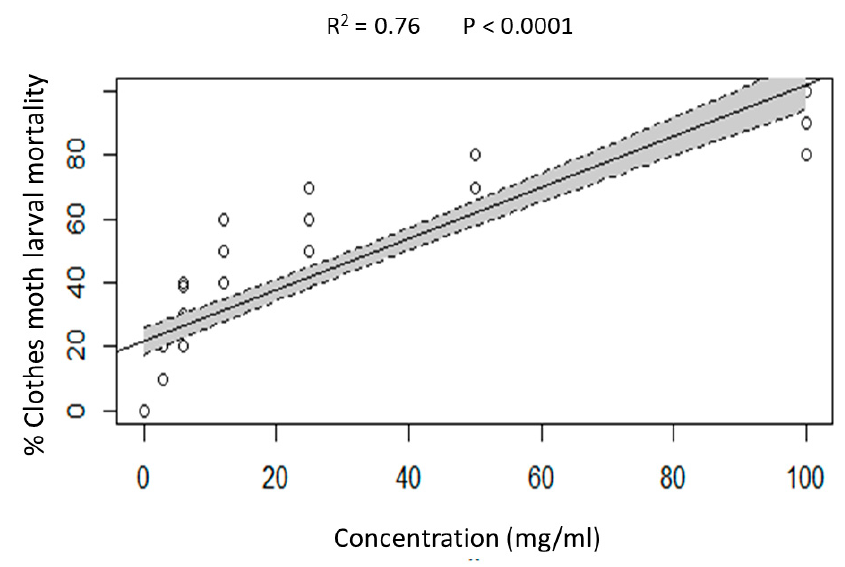
Figure 4. Linear regression plots with 95% confidence intervals (shaded areas) showing the predicted relationship between disodium octaborate tetrahydrate (DOT) concentration and mortality of clothes moth larvae exposed to treated wool for seven days.